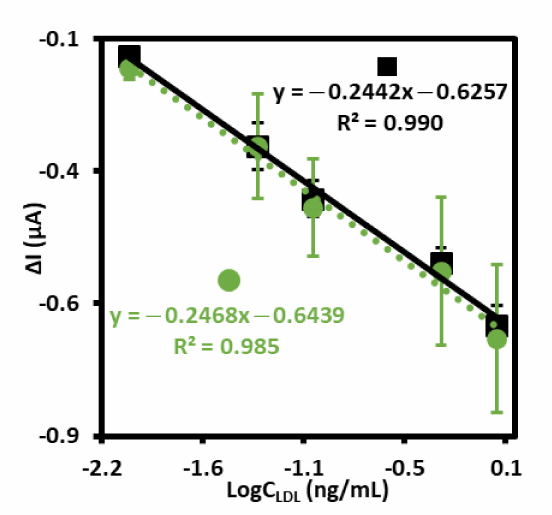
Figure 6. The calibration curves of aptasensor to LDL standard solution with different concentra- tions (0.01–1.0 ng/mL) ( (cid:4) solid line), and to LDL standard solution with different